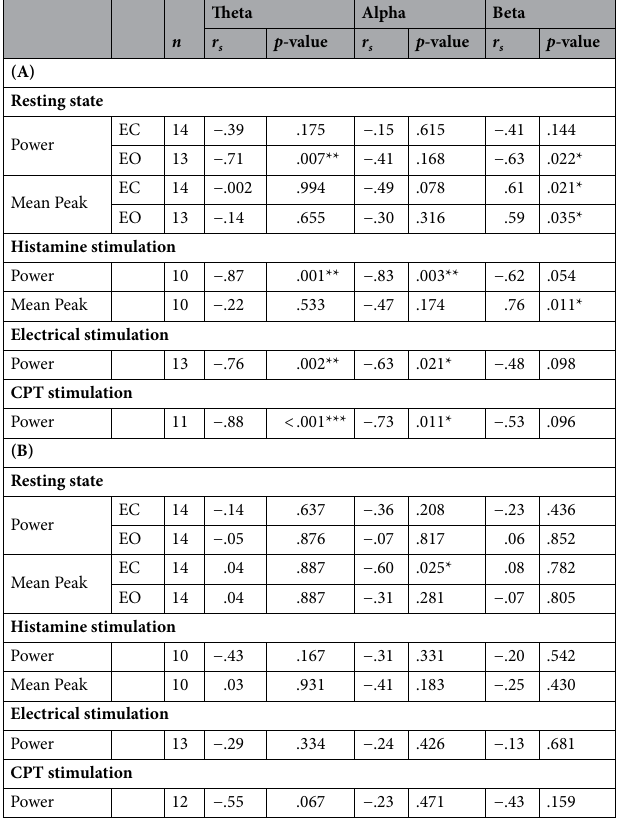
Table 6. Spearman’s correlation coefficient ( r s ) between (A) patients’ (B) healthy controls’ age and power and mean peak frequencies during rest, with eyes closed (EC) or eyes open (EO), and stimulation states in